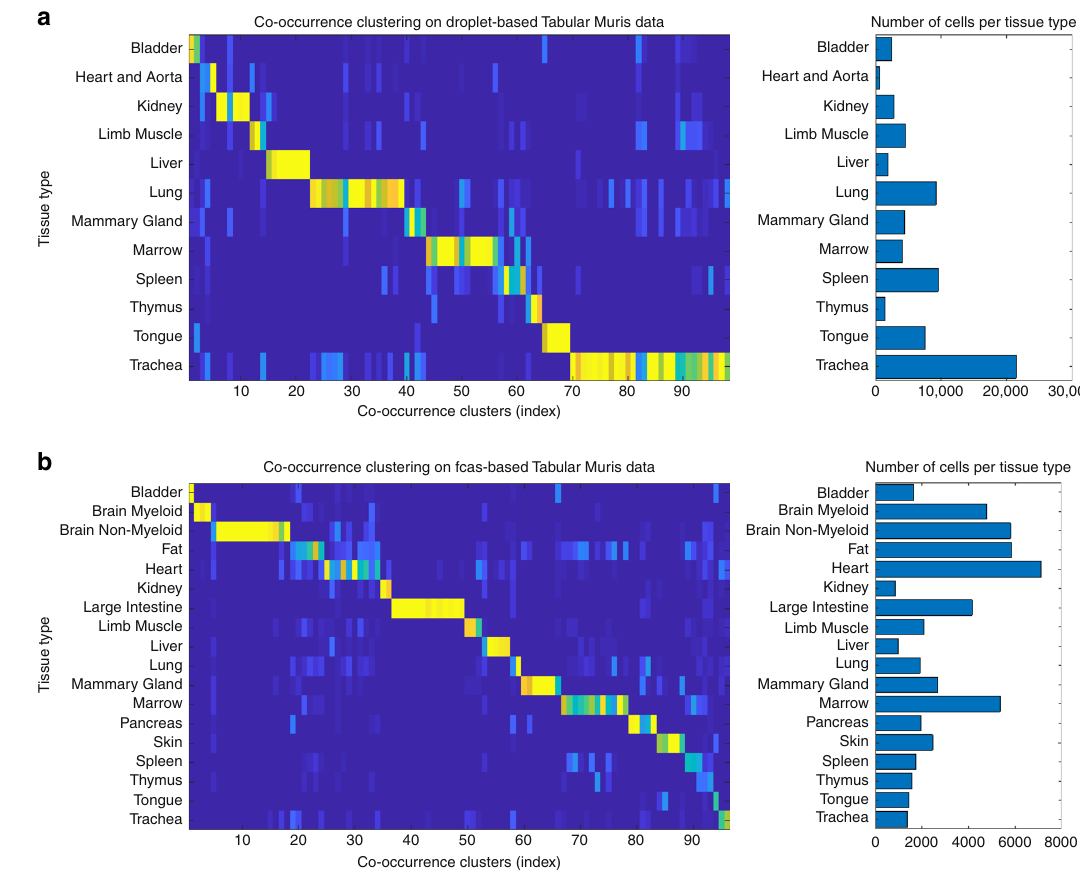
Fig. 4 Co-occurrence clustering applied to dropout patterns in the Tabula Muris datasets. a Co-occurrence clustering separated tissue types in the droplet-based scRNA-seq data. b Co-occurrence clustering separated tissue types in the FACS-based scRNA-seq